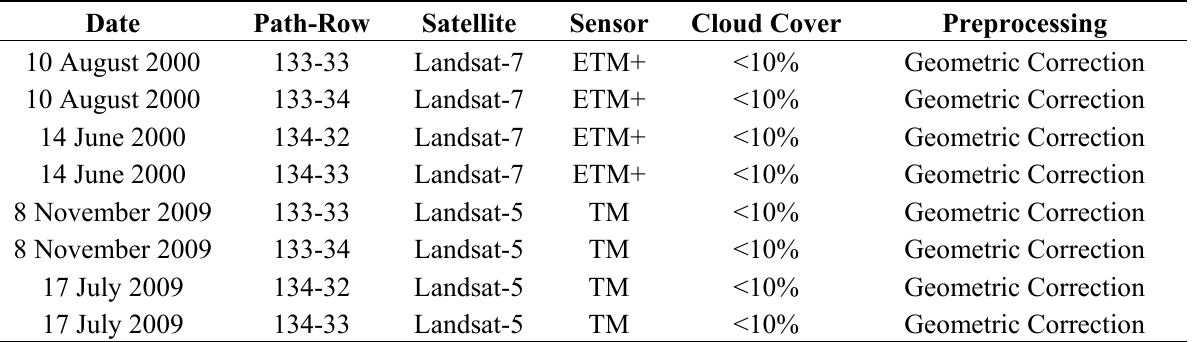
Table 1. Satellite images used in this